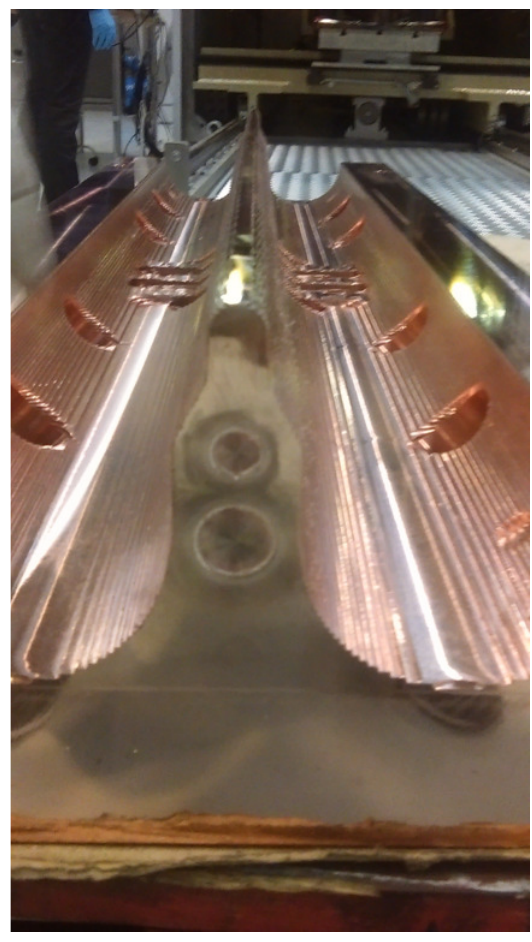
Figure 21. A major vane after cooling channels plugs have been inserted and welded by EBW.